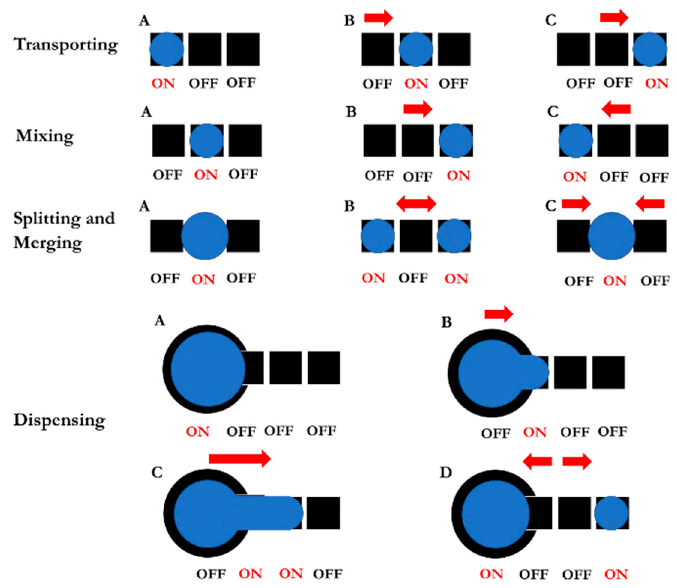
Figure 6. Characteristics of electrode design for controlling various liquid droplets, where the droplet controlling steps for each manipulation category are shown in alphabetical order.